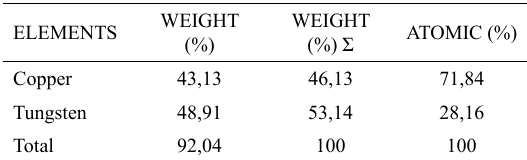
Figure 9. SEM micrograph of W-30 wt% Cu (a) 100x and (b) 7000x and (c and d) Mapping by EDS. Table 1. Percentage of components in W-30 wt% Cu by